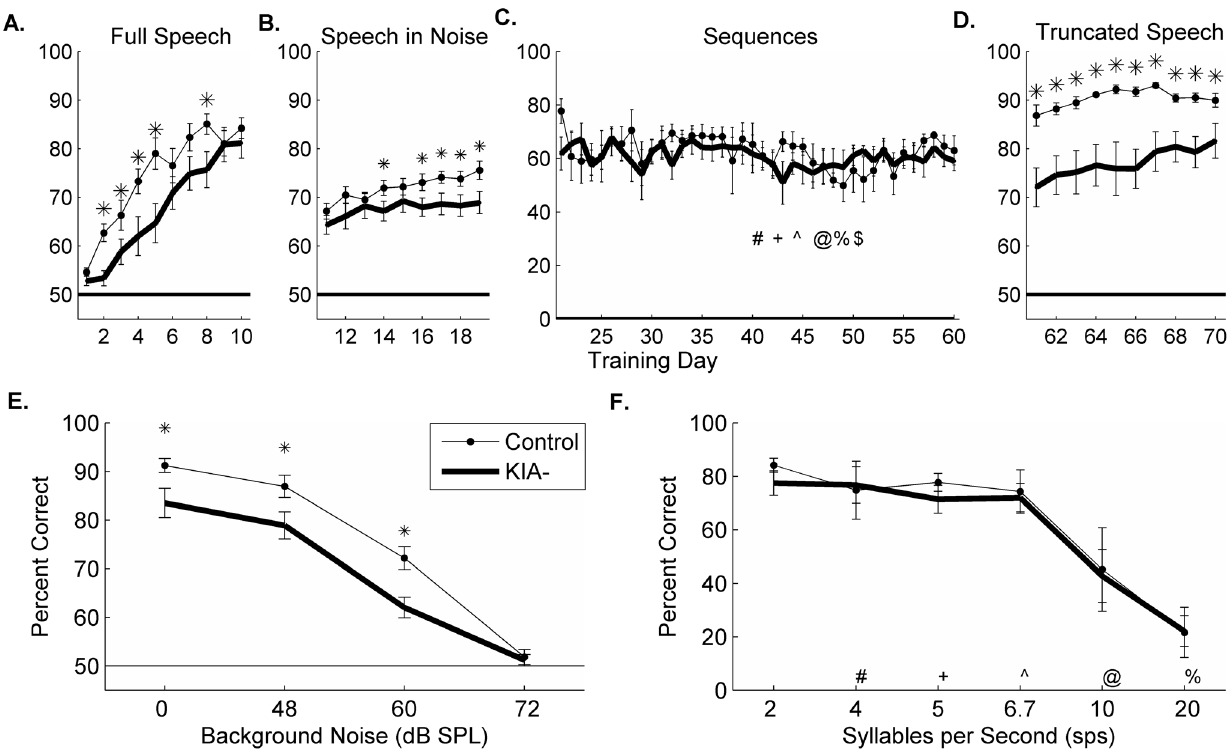
Figure 2. Extensive speech discrimination training can improve on clear speech tasks. Horizontal lines in each panel represent chance performance for that task. A . Timeline of performance on the full length speech task. After an additional week of training, 8 KIA- rats were able to perform the full speech task at the same level as 5 control rats (unpaired t-test, p=0.24). B . Timeline of performance on speech in noise task. KIA- rats remained significantly below control levels at the end of training (*=p , 0.05). C . Timeline of performance on sequence task. There were no significant differences between control and KIA- rats during this 40 day training period. Symbols correspond to the first day of training at each new stage (see panel F for symbol key). D . Timeline of performance on truncated speech task. KIA- rats were significantly impaired at this task compared to controls until the final day of training (*=p , 0.01). E . Last day performance of rats on the speech in noise task. (*=p , 0.01). F . Last day performance of rats on the sequence task. There were no significant differences between control and KIA- rats at any presentation rate tested (2 sps,